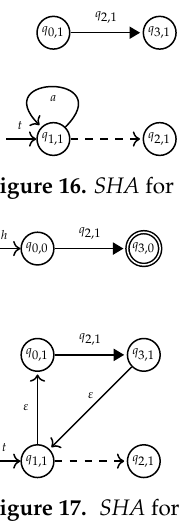
. a ∗ (cid:104) (cid:105)